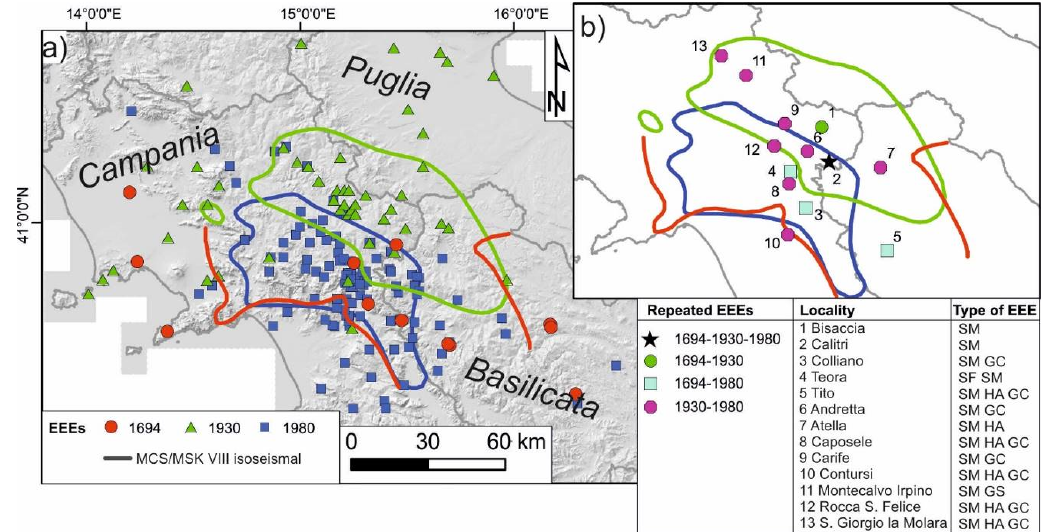
Figure 3. Map ( a ) shows a comparison between the VIII isoseismals of the 1694, 1930 and 1980 earthquakes and the location of EEEs; map ( b ) shows the localities where EEEs were documented for more than one seismic event (SM: slope movement, GC: ground crack, SF: surface faulting, HA: